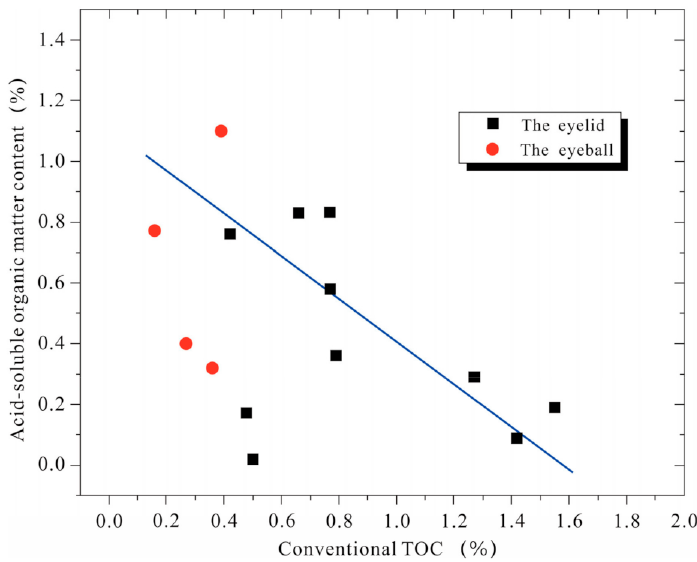
Figure 5. Correlation diagram of acid-soluble organic matter content and TOC in the Permian Maokou Formation, Sichuan